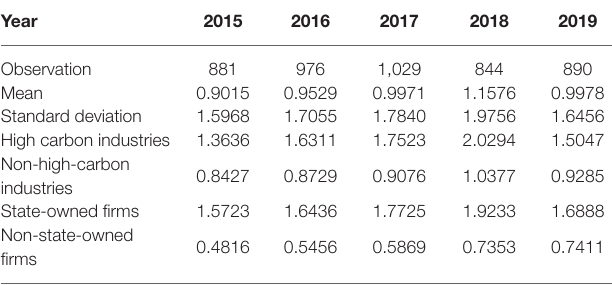
TABLE 3 | Descriptive statistics of CDI.